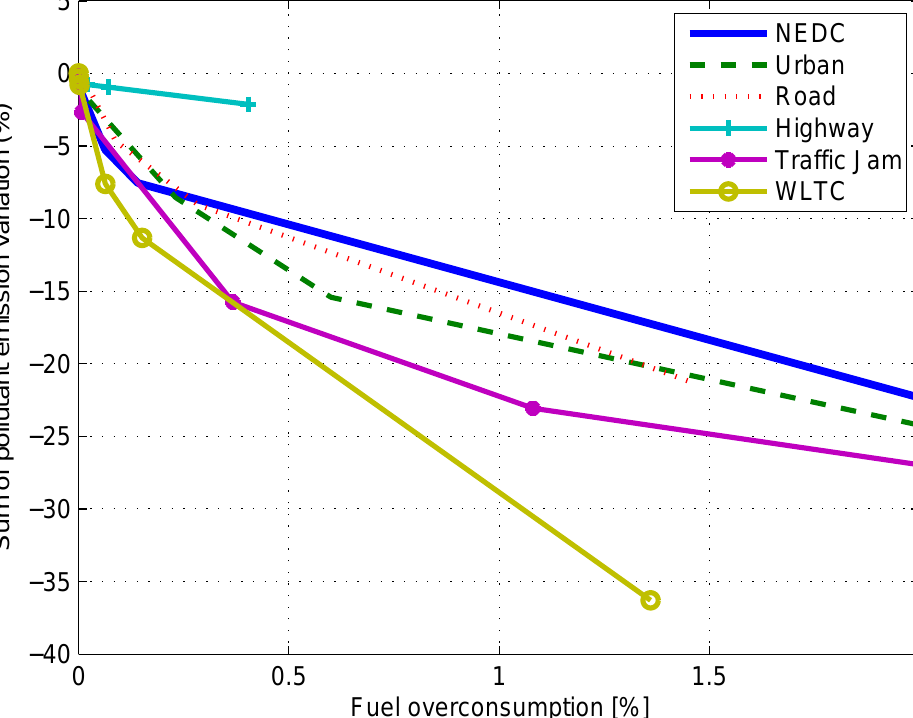
Figure 2. Trade-off between fuel consumption and pollutant emission for different driving